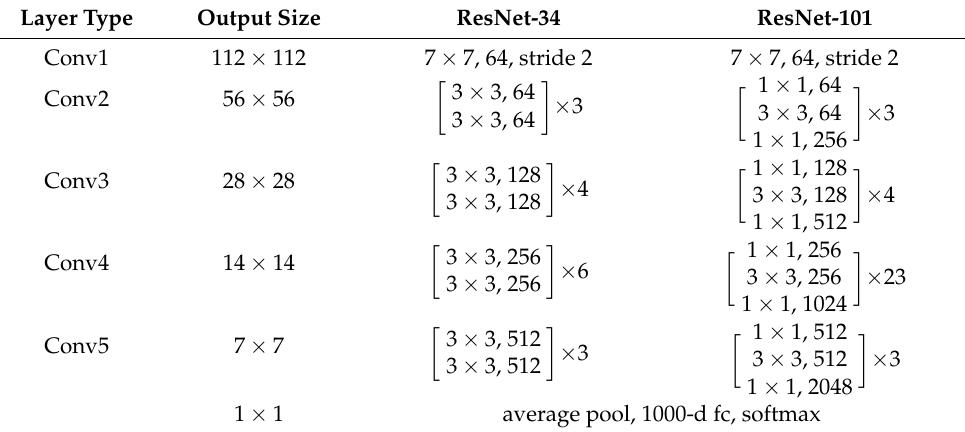
Table 4. The network configurations for the teacher and student models in our experiments. Layer